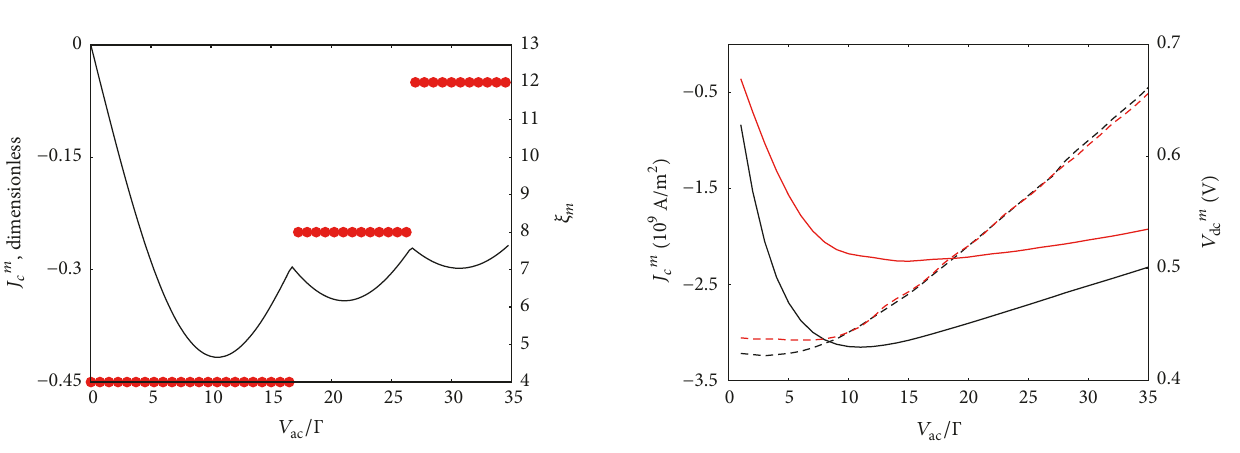
Figure 8: Maximum absolute value of the negative active current 𝐽 𝑐𝑚 (solid line, left 𝑦 axis) and its position relative to the energy of the resonant level 𝜉 𝑚 = (𝜀 − 𝜀 𝑅 )/Γ (dashed line, right 𝑦 axis) as a function of amplitude of the AC electric field for RTD heterostructure number 2 at the following frequencies: ℏ𝜔 = 0.1Γ (black line) and ℏ𝜔 = 2Γ (red